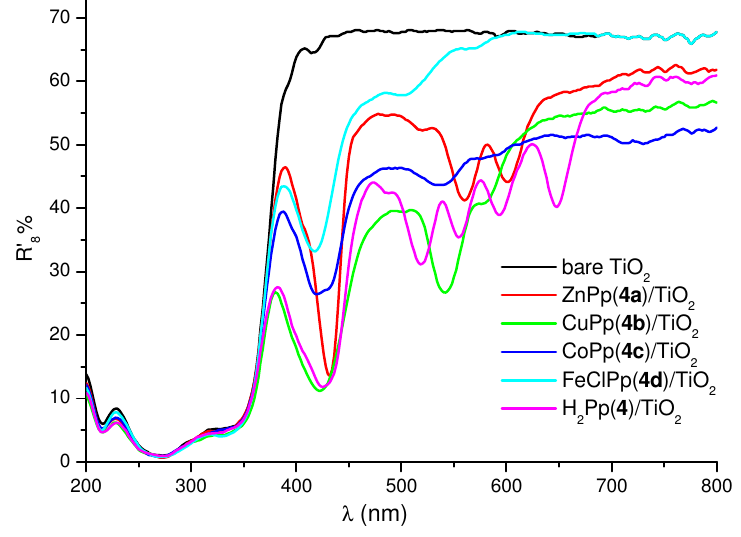
and differently loaded samples obtained 2 with H Pp 4 or MPp 4a–4d 2 2